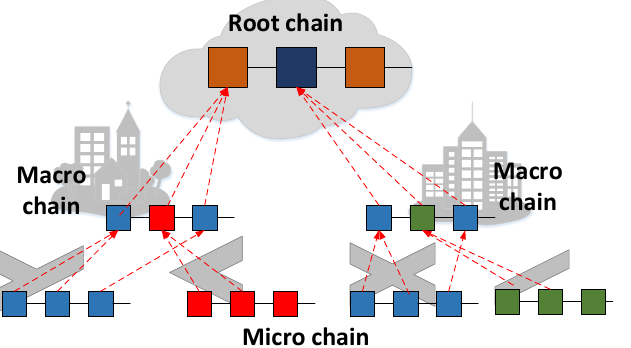
Figure 3. Example of a hierarchical autoCoin blockchain that consists of multi-layers such as root, macro and micro blockchains. The macro chain covers a city area and the micro-chain deals with small districts or several